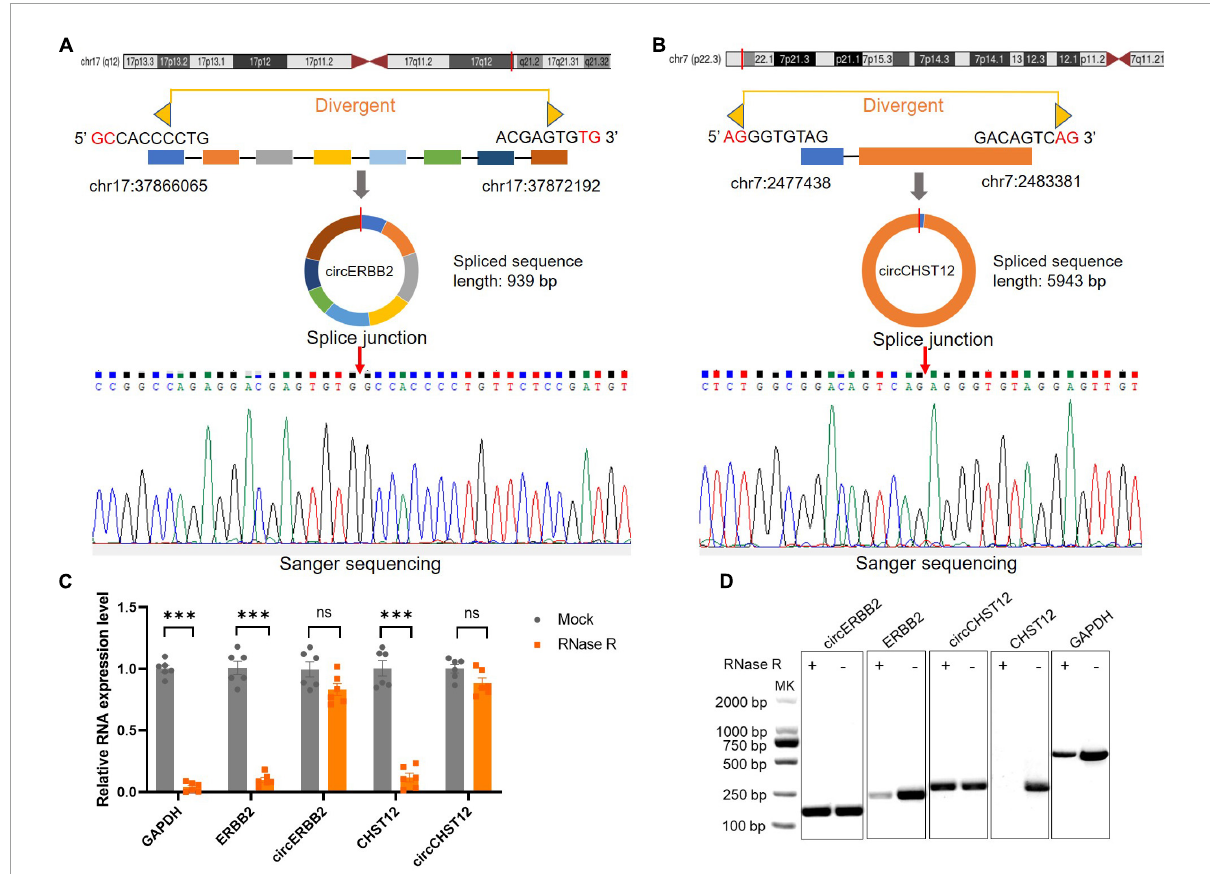
FIGURE4 Identification of novel circular RNAs circERBB2 and circCHST12. (A,B) Schematic diagrams and Sanger sequencing illustrated the back-splice junction site of circERBB2 (A) and circCHST12 (B) . (C) RT–qPCR showed the expression of GAPDH , ERBB2 , circERBB2 , CHST12 and circCHST12 administered RNase R or mock control ( n = 6 per group). (D) Representative agarose gel pictures showing the relative expression of GAPDH , ERBB2 , circERBB2 , CHST12, and circCHST12 administered RNase R or mock control. Data are presented as the mean ± standard deviation. ∗∗∗ p < 0.001. ns: no significant. Statistical significance was assessed using unpaired two-tailed Student’s t